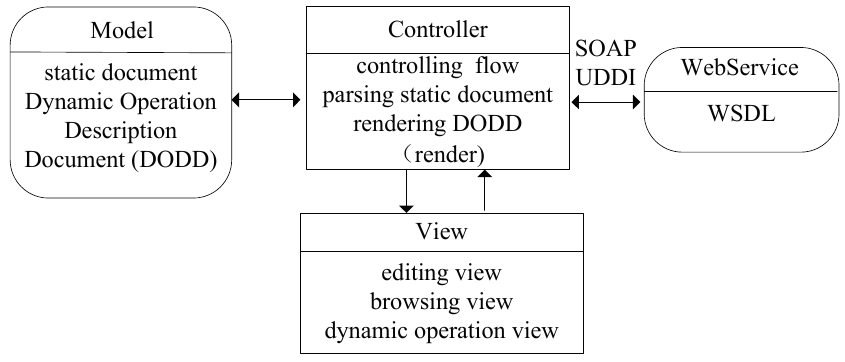
Figure 1. Intelligent Document Model based on